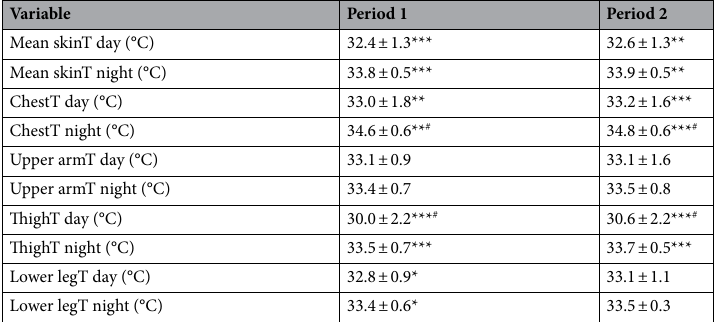
Table 2. Skin temperatures during the day and night of both periods. Values are mean ± SD. “T” denotes temperature. “Day” includes data collected between 07:00 and 19:00 and “night” includes data collected between 19:00 and 07:00. Period 1 and period 2 are 6 days each. For all skin temperature parameters, n = 12. Data were analysed with paired t-tests. Significant differences between periods 1 and 2 are indicated by: # P < 0.05. Significant differences during the day and the night, within periods, are indicated by: *P < 0.05, **P < 0.01 and ***P < 0.001.